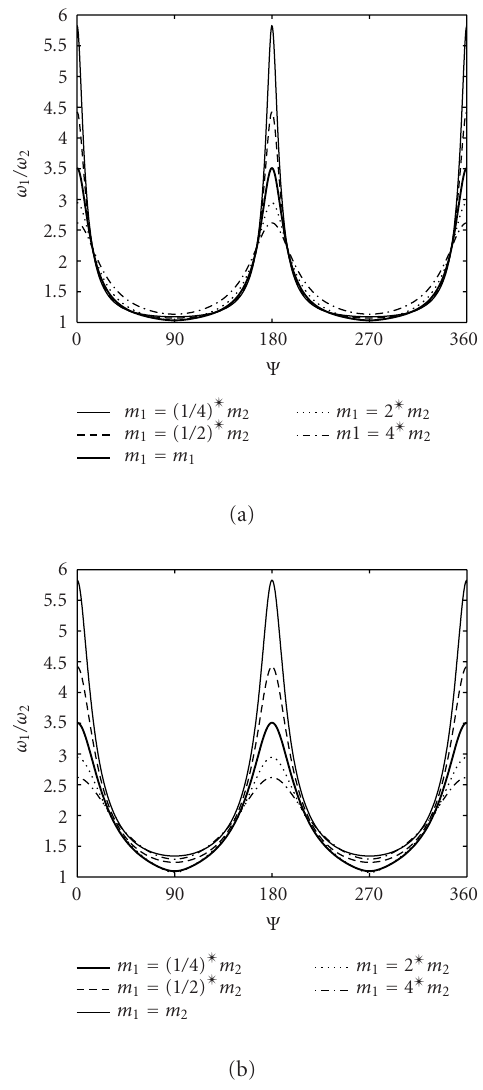
Figure 4.5. The ratio of frequencies versus angle between the oscillation planes for point masses ratio and small length of first pendulum. The initial parameters for (a) L 1 = 0 . 2 m, L 2 = 5 · L 1 , m 2 = 2kg; and for (b) L 1 = 1m, L 2 = 5 · L 1 , m 2 = 2